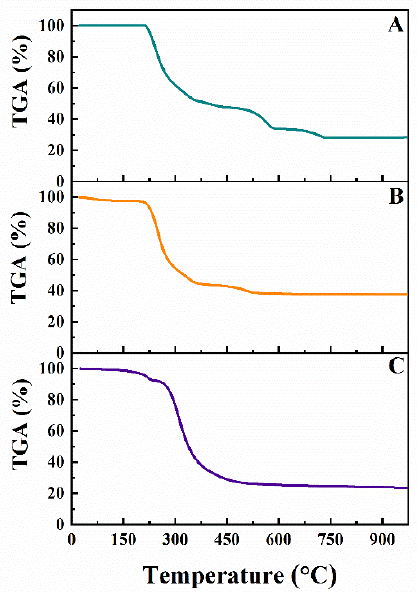
Figure 6. TGA data for as-deposited composite coatings: ( A ) PEMA-huntite, ( B ) PEMA-halloysite, and ( C ) and ( C ) PEMA-hydrotalcite.